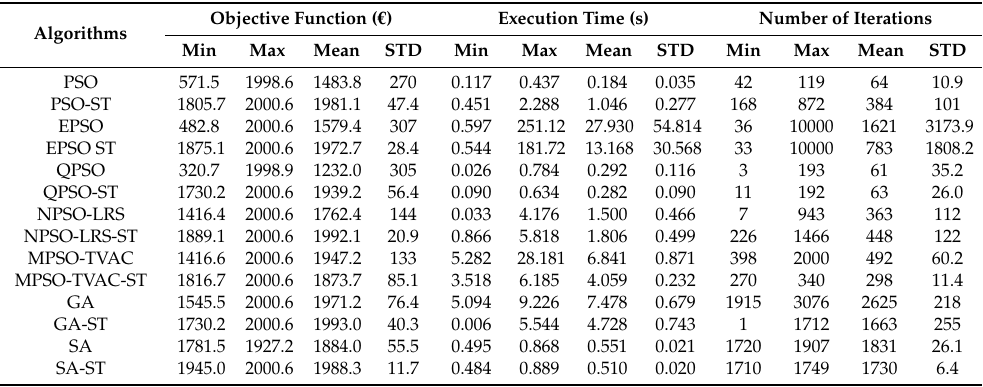
Table 2. Optimization results for the different methods.